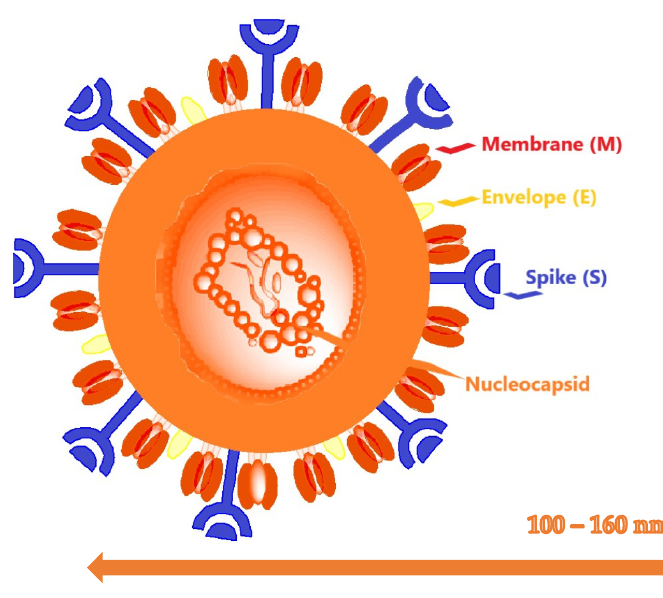
Figure 2. The SARS-CoV-2 virus structure.